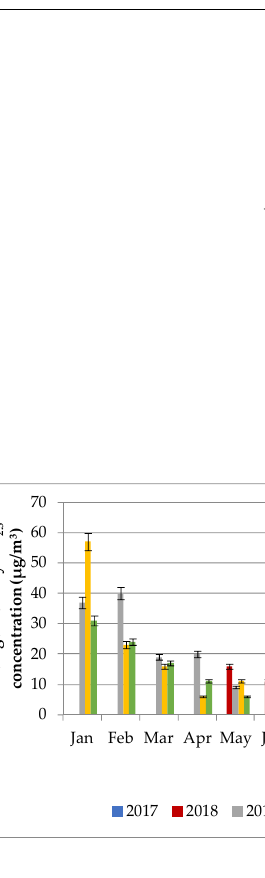
Figure 10. Average monthly PM 2.5 concentrations at locations A and D between 2017 and 2021 (from left to right).